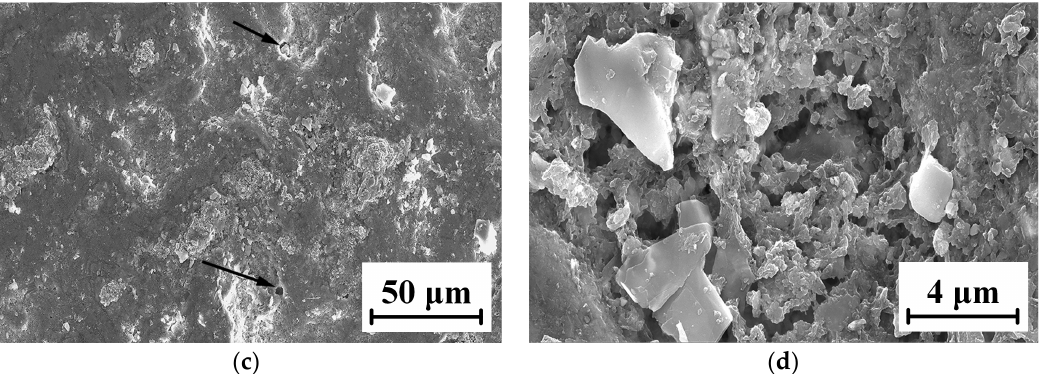
Figure 22. Micro-morphology of the TC18 substrate and the WC-12Co coating surface after corrosion. ( a ) Substrate surface morphology at 3 K times magnification; ( b ) Substrate surface morphology at 10 K times magnification; ( c ) Coating surface morphology at 1 K times magnification; ( d ) Coating surface morphology at 10 K times magnification. The microscopic morphology of the WC-12Co coating sample after neutral salt spray with many holes, cracks and other defects. When NaCl as corrosion medium is sprayed onto the coating surface, the bonding phase Co with a high corrosion potential is prefer- entially corroded. However, the NaCl corrosion medium does not penetrate the binding layer between the coating and substrate, and the substrate does not corrode. The WC-12Co coating can effectively improve the corrosion resistance of the TC18 titanium alloy in a neutral salt spray corrosive environment.